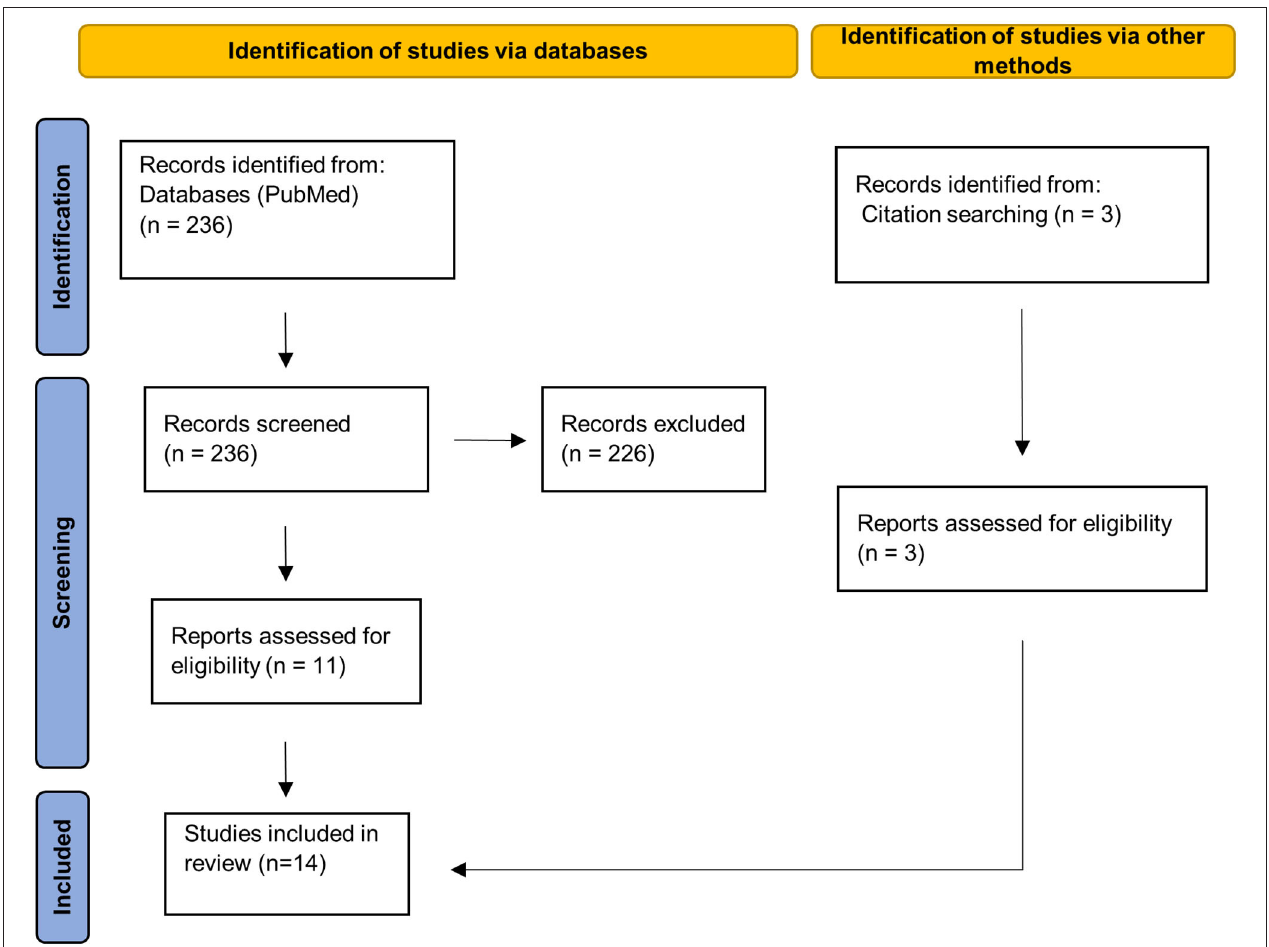
FIGURE 1 | PRISMA 2020 flow diagram. Page et al. (43). For more information, visit: